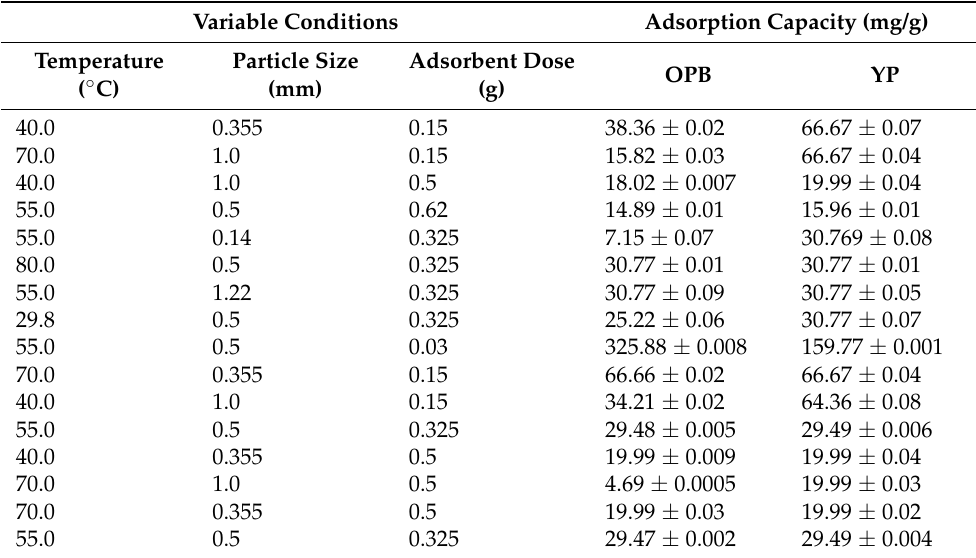
Table 4. Experimental results for adsorption capacity of Cr (VI) onto OPB and YP, evaluating the effect of temperature, particle size and adsorbent